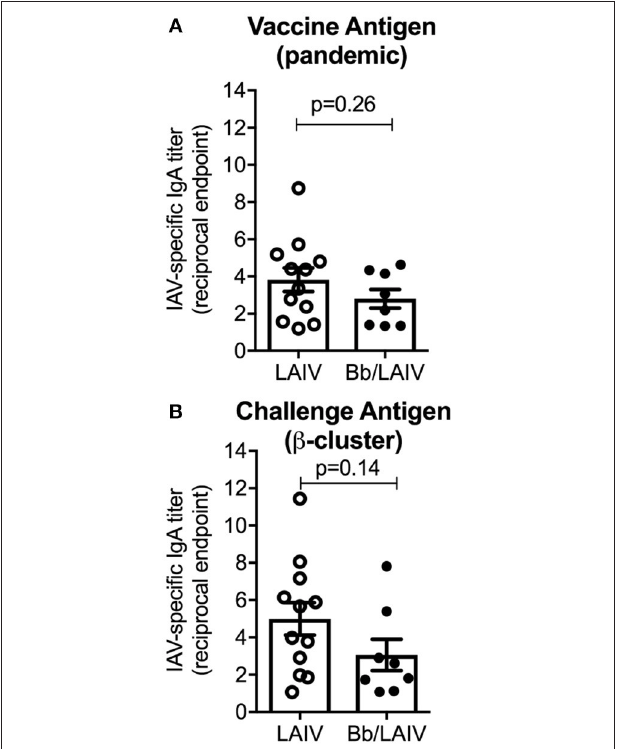
FIGURE 6 | B. bronchiseptica colonization did not alter the development of IAV-specific mucosal IgA following LAIV administration. Groups of pigs were inoculated with B. bronchiseptica (Bb) on day − 7, LAIV on days 0 and 21, and nasal wash collected on day 42 as described in materials and methods. Titers of IgA in nasal wash specific to (A) vaccine virus and (B) challenge virus were determined using a whole virus ELISA to evaluate the impact of Bb on LAIV immunogenicity. Data was analyzed using an unpaired students t -test (GraphPad Prism 6) and there were no significant differences between groups ( p > 0.05).